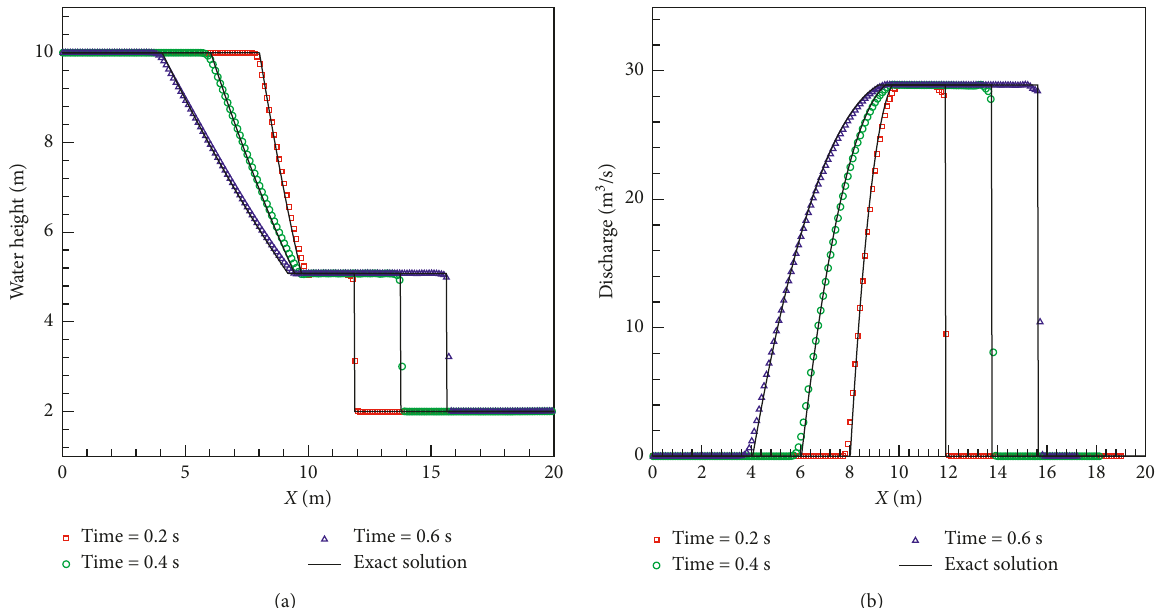
Figure 2: Zoom-in view of Figure 1, focusing on discontinuities in the water